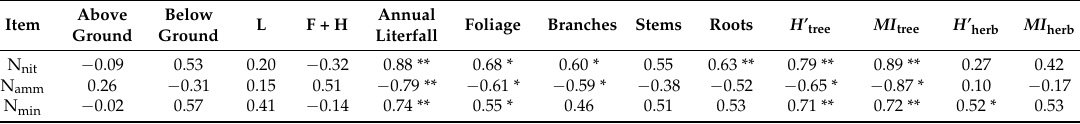
Table 5. Pearson’s correlation coefficients (r) between plant variables and soil N mineralization ( n = 12).